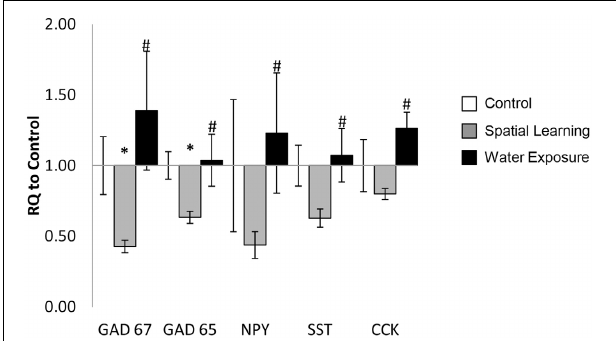
FIGURE 2 | Stress-specific change of GABA-related gene expression in the BLA. The mRNA expression levels of the selected GABAergic marker genes GAD65 and GAD67 as well as the neuropeptides neuropeptide Y ( NPY ), somatostatin ( SST ), and cholecystokinin ( CCK ) were decreased in the in BLA 5h after spatial learning in the water maze, but not after exposure to the maze only. Values are shown as relative quantification to handled controls [RQ; RQ ( Control ) = 1] and mean ± s.e.m. per group. ∗ Significant difference from Control with p < 0 . 05; # significant difference between Spatial Learning and Water Exposure groups with p < 0 . 05.